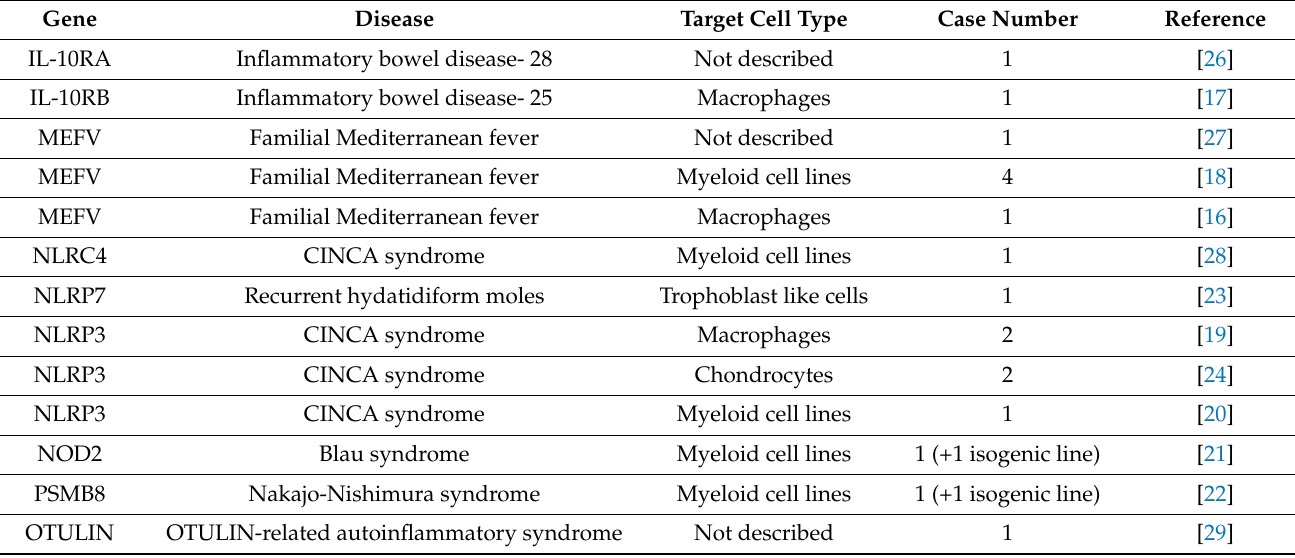
Table 1. Induced pluripotent stem cells (iPSCs) established from autoinflammatory disease patients. Responsible genes in the Infevers database [25] were searched on